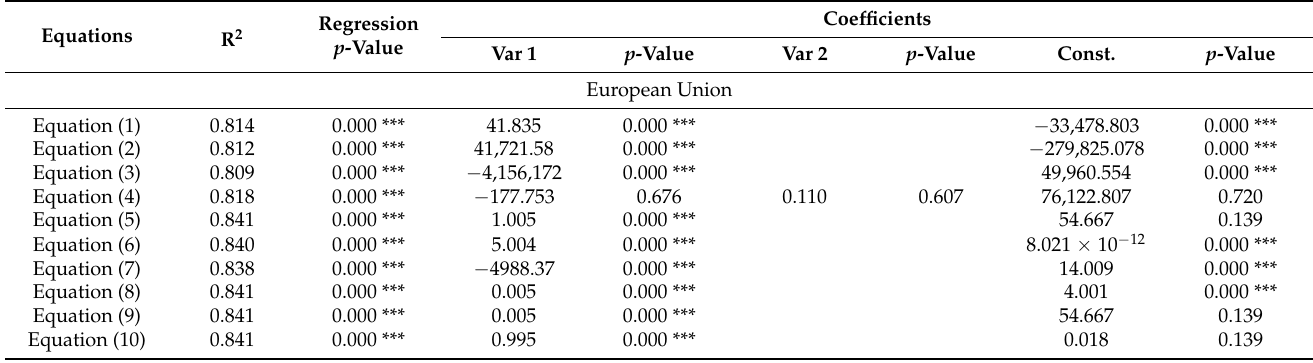
Table A2. Estimation of parameters of linear and nonlinear equations for GDP and FEC